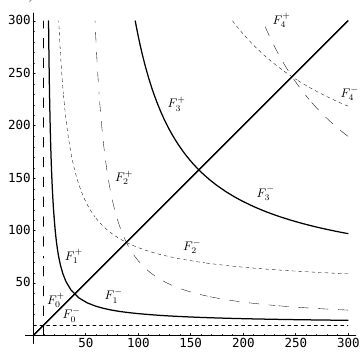
Figure 1. The classical Fučik